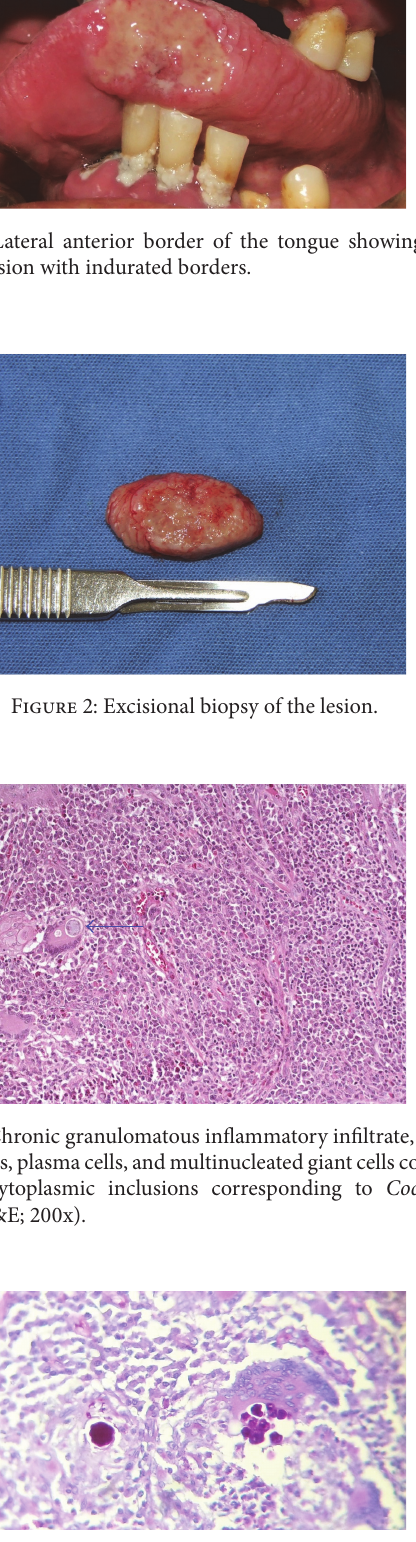
Figure 4: C. PAS staining highlighting various bodies of C . immitis in red color (PAS).